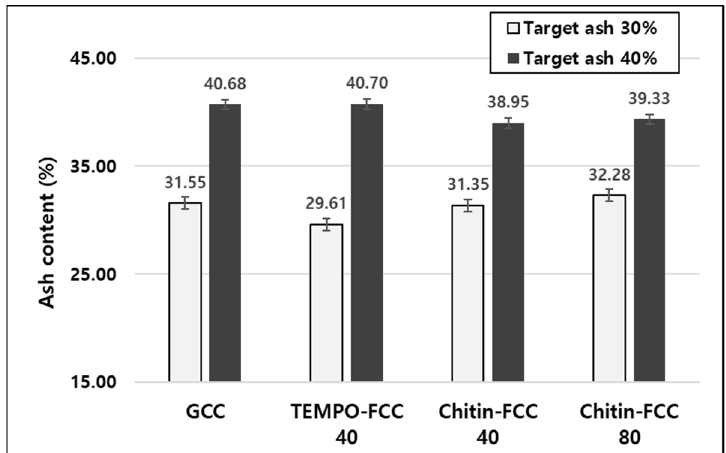
Figure 4. Ash content of the papers containing three different fillers.